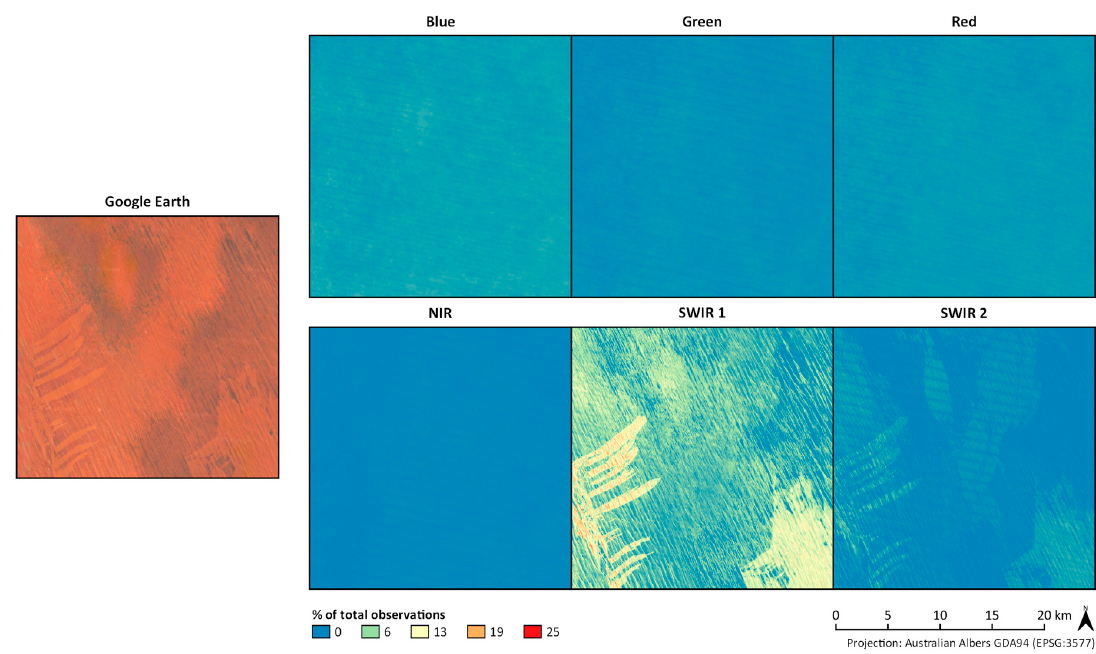
Figure 9. High-resolution imagery (Google, CNES/Airbus), saturation flags in the visible, NIR, and SWIR bands in percent of total observations. Simpson Desert, NT.